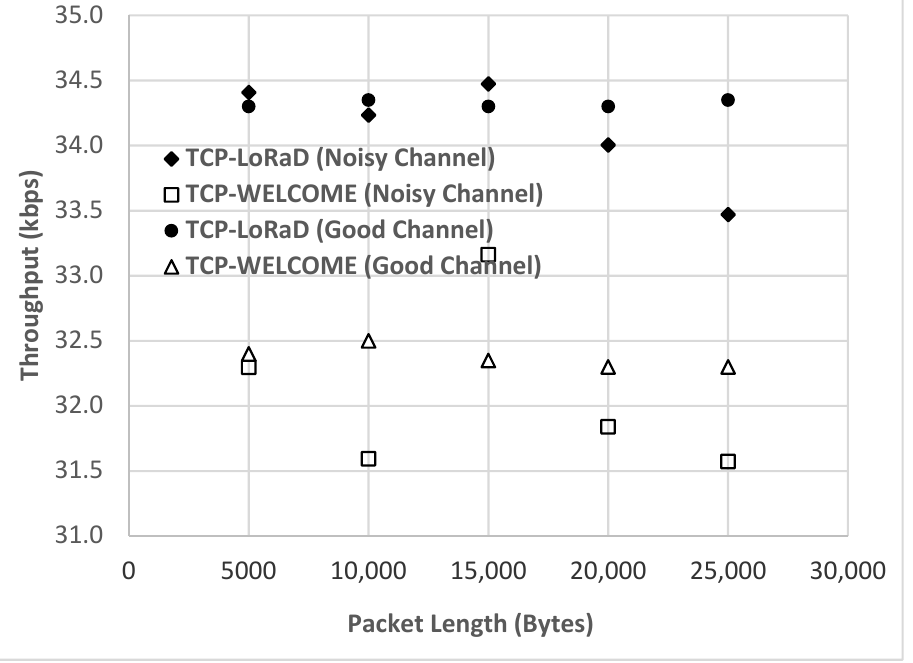
Figure 14. End-to-End delay versus Packet Length in a noisy channel. Comparison of TCP-